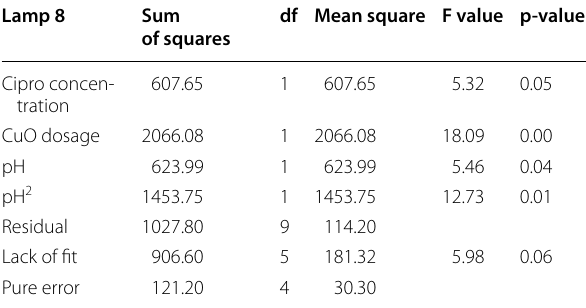
Table 3 Analysis of variance (ANOVA) results for the fitted polynomial model for COD removal using photocatalytic process with lamp 8-W